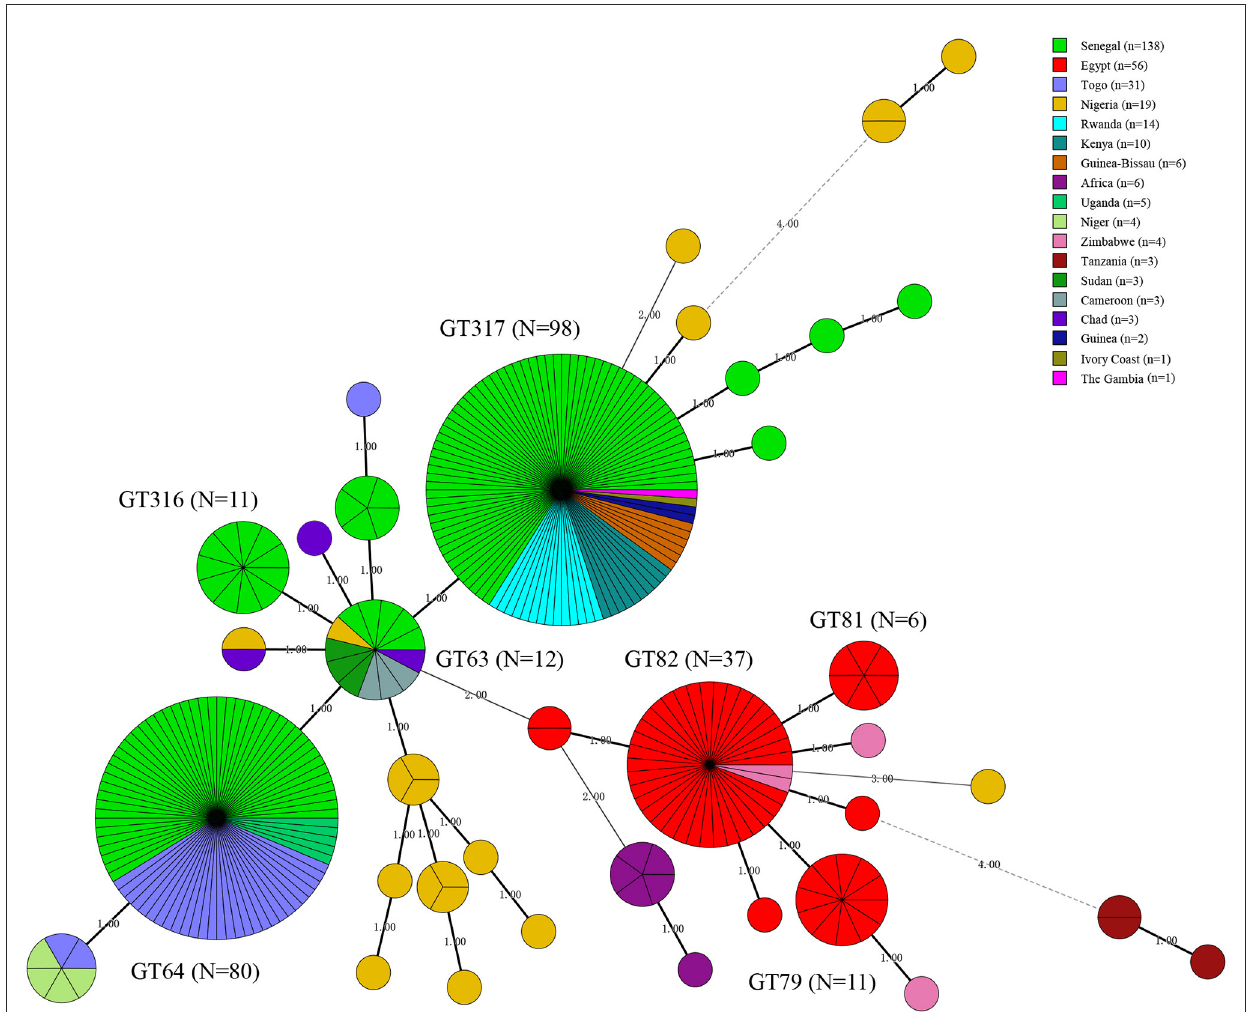
FIGURE3 Minimal spanning tree (MST) of MLVA-11 genotype geographic distribution based on the multi-loci variable number of tandem repeats (VNTR) 11 data from West African Brucella abortus strains. Color coding according to countries distributed of MLVA-11 genotypes (the detail genotype profile is presented in Supplementary Figure S2), the predominated MLVA-11 genotypes in the present study were marked with the bold in figures. Circle size indicates the number of strains, GT indicates MLVA-11 Genotype. The number on the horizontal line is the number of site differences between